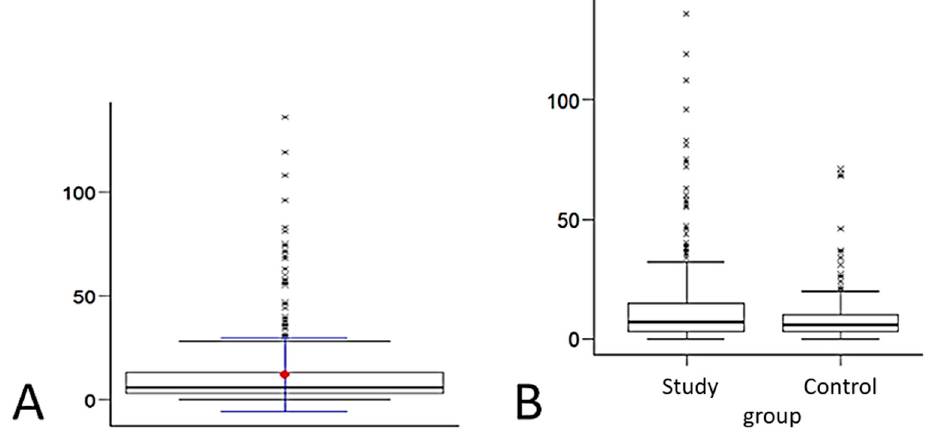
Figure 5. Number of points marked in the tactile test—Test I: ( A ) mean number of points and ( B ) distribution of variables. Table 4. Mann–Whitney U Test for independent trials—Test I.